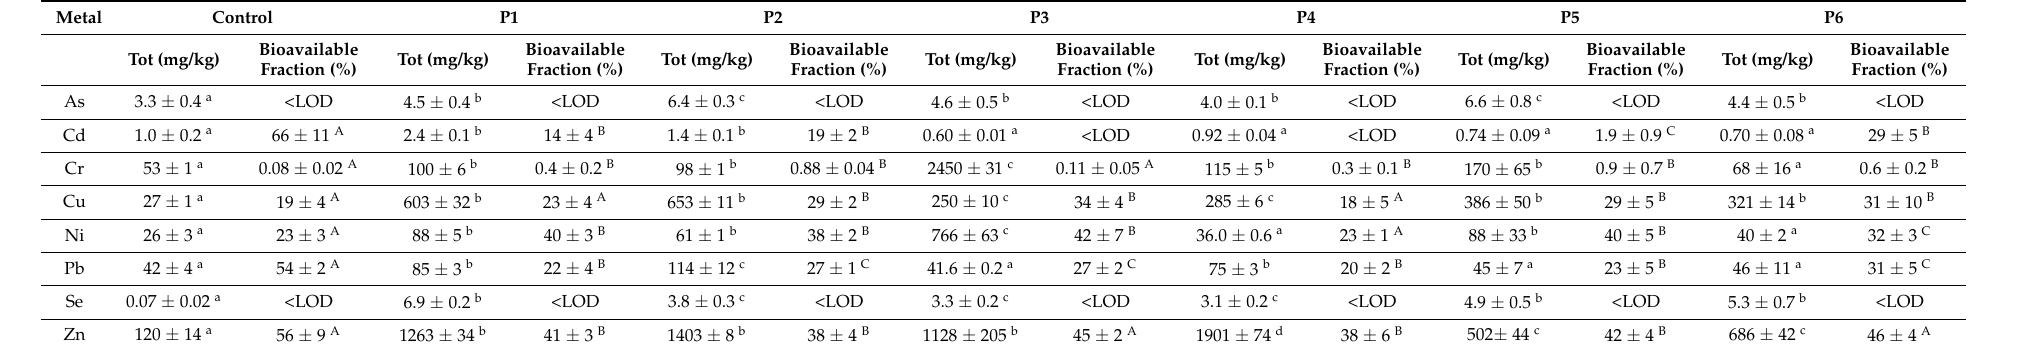
Table 2. Average metal total concentrations and bioavailable fractions in SS from different WWTPs and control soil before remediation. Small and capital letters indicate significant differences within, respectively, total contents and bioavailable fractions of each specific metal among different SS samples and control soil (Kruskal-Wallis test, followed by the Dunn’s test, p < 0.05). LOD, limit of detection. Complete dataset in Table